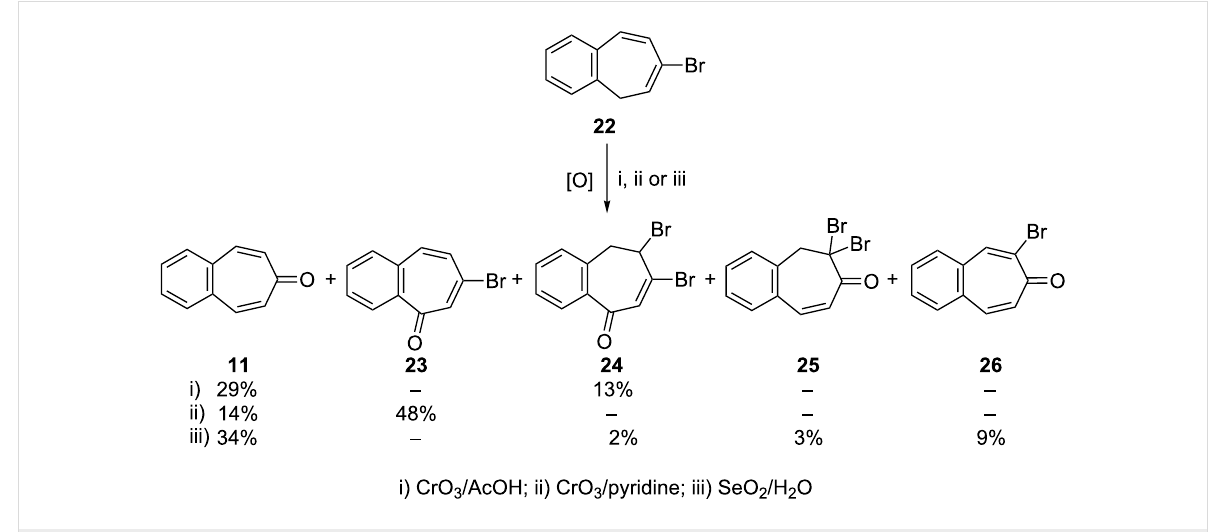
Scheme 4: Oxidation of 7-bromo-5 H -benzo[7]annulene ( 22